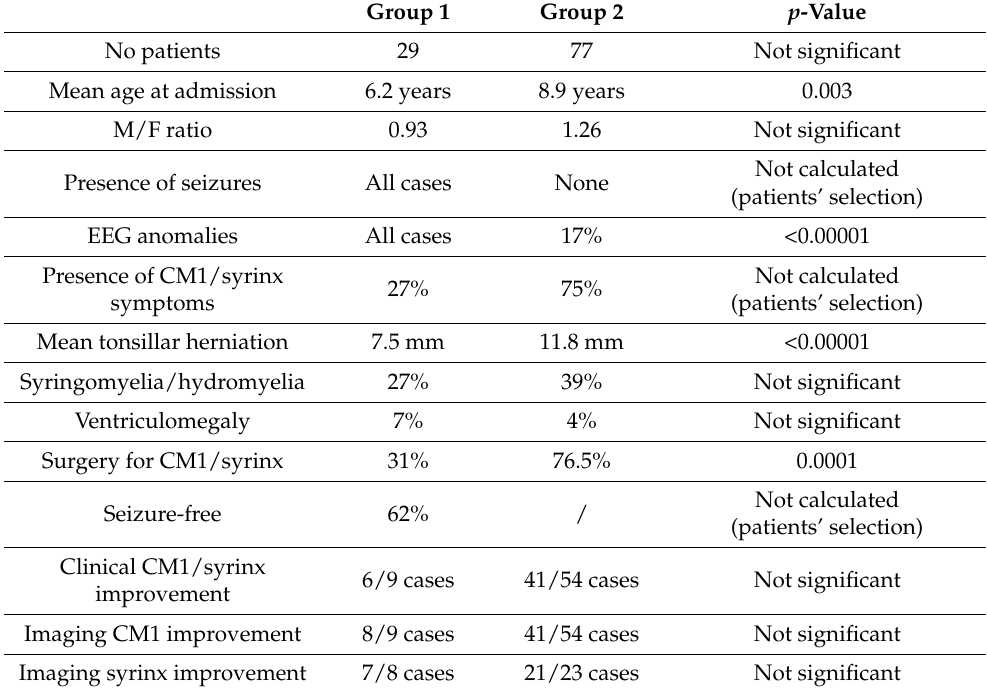
Table 5. Comparison between the two